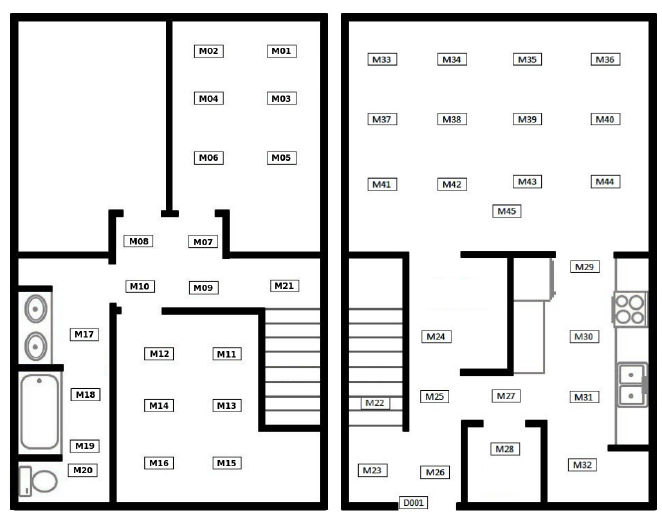
Figure 1. Blueprint of the WSU CASAS living lab, showing the location of contact ( D ) and motion ( M ) sensors. After Crandall & Cook